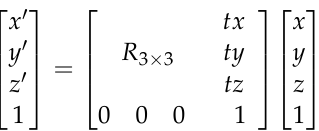
where tx , ty and tz represent the shifts in the x, y and z directions respectively. R 3 × 3 is the